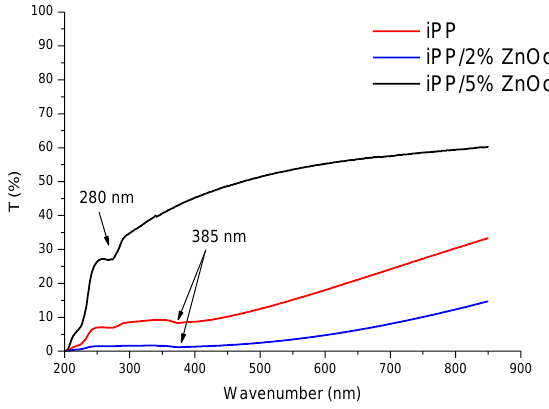
Figure 6. UV-Vis spectrum of iPP and iPP/ZnOc samples.